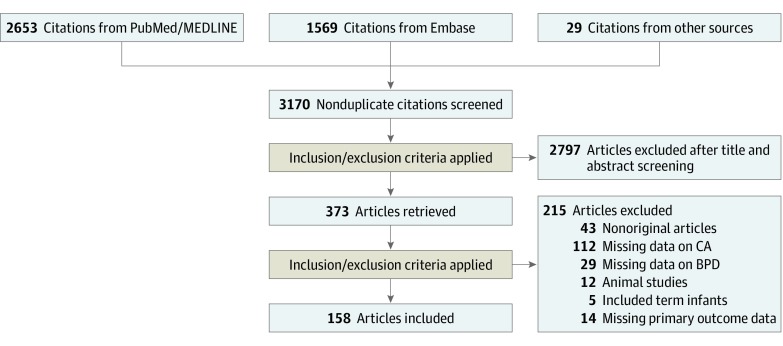
PRISMA Flowchart of the Systematic SearchBPD indicates bronchopulmonary dysplasia; and CA, chorioamnionitis.